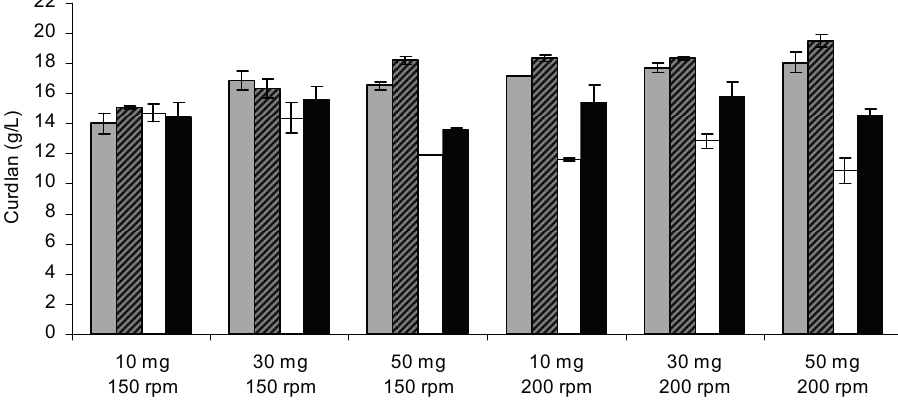
Figure 1. Curdlan production by Agrobacterium sp. IFO 13140. Free cells after 48 h (open bars) and 72 h of incubation (closed bars black); immobilized cells after 48 h (closed bars gray) and 72 h of incubation (closed bars striped). Assay conditions: 10 days of incubation in production medium at 30 °C and 150 rpm. The error bars represent standard deviations of